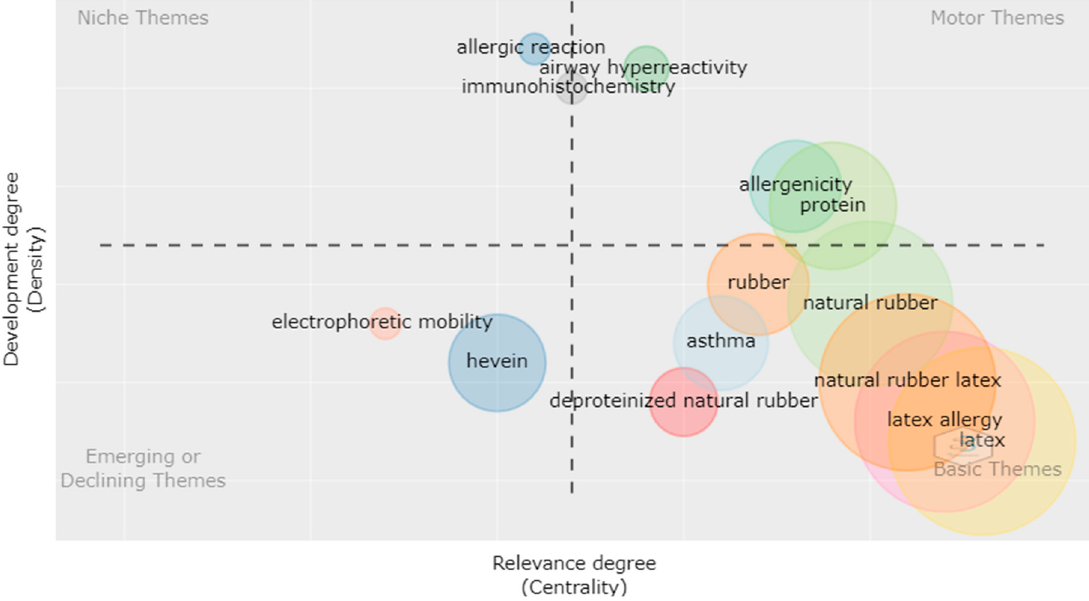
Figure 3. DPNR Author Keywords Strategy Chart (Bibliometrix).